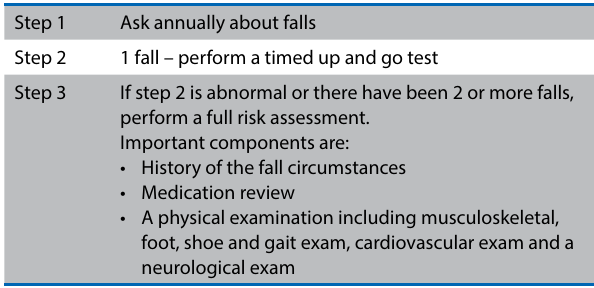
Table 3: The falls risk assessment